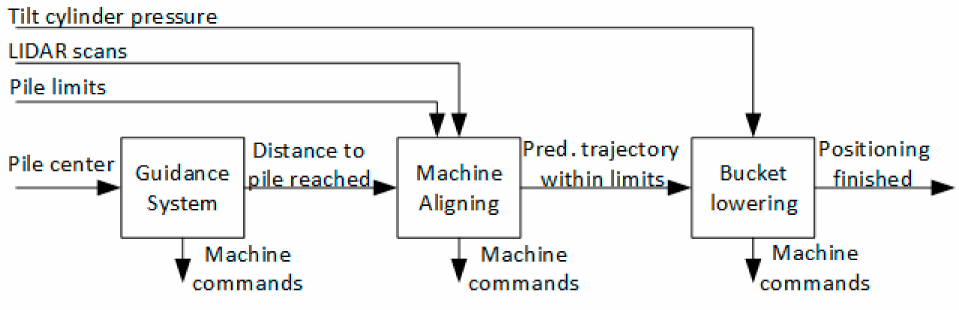
Figure 11. Positioning block diagram. The machine is driven by a guidance system until a predefined distance to the rock pile is achieved. The steering angle of the LHD is then adjusted to ensure collision with the pile, and the bucket is